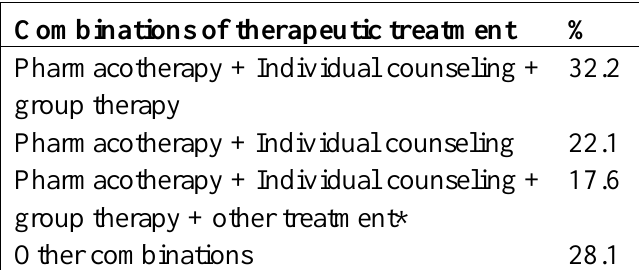
Table 3. Tobacco-use Cessation Programs.